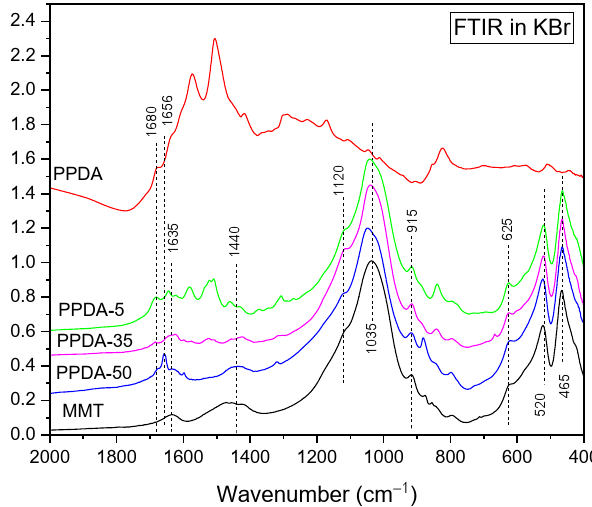
Figure 4. FTIR spectra of selected MMT, PPDA and their composites. The spectra were baseline corrected, normalized and shifted for clarity.